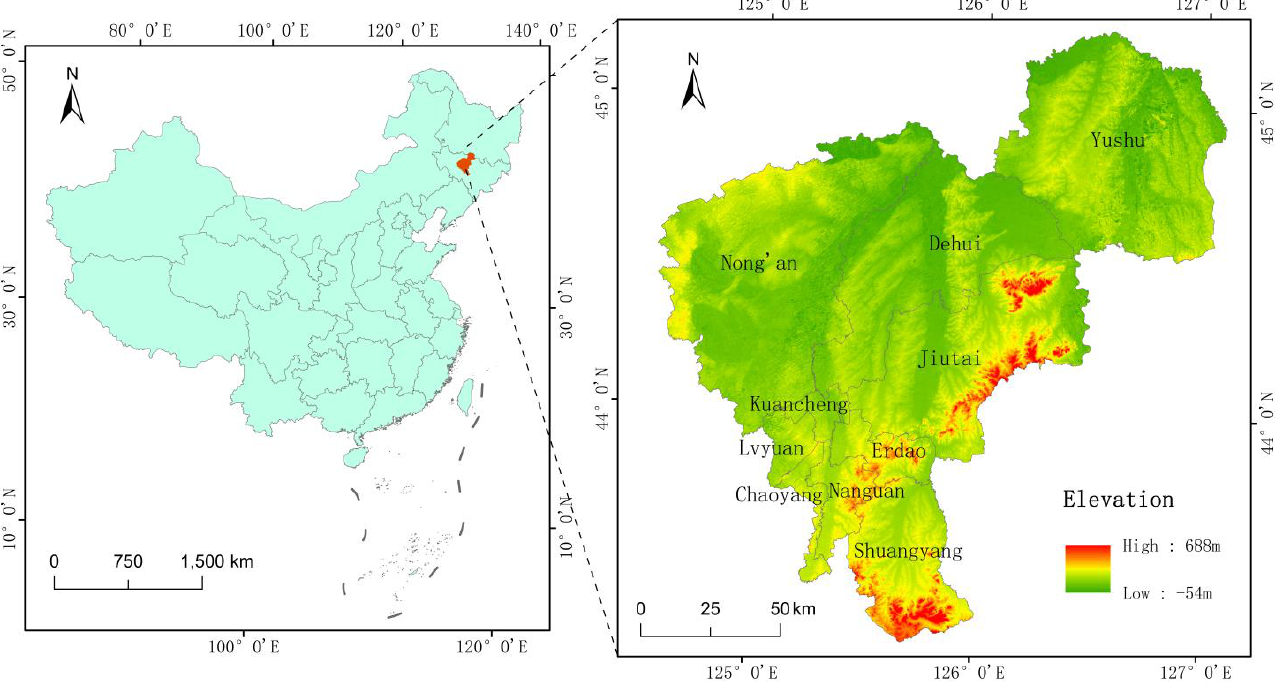
Figure 1. Diagram of the study area (Projected Coordinate System: Map of China: Krasovsky_1940_Albers; Map of Changchun: WGS_1984_UTM_Zone_52N).